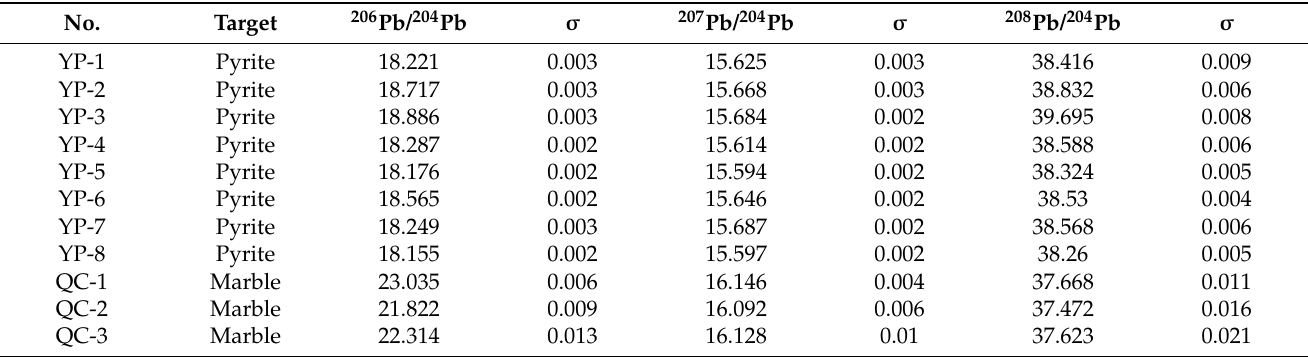
Table 3. Lead isotope ratios of ore-bearing pyrites and marbles from the Lijiapuzi gold